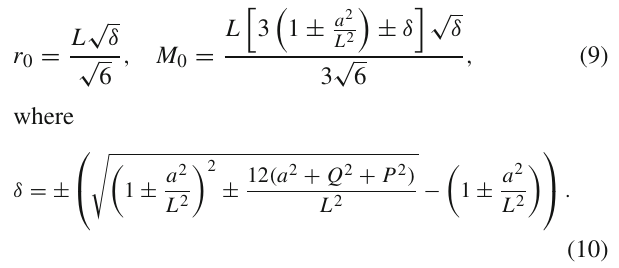
Fig. 1 Chartofchargedblackholesfromthe(A)dSspacetotheasymp- totically flat